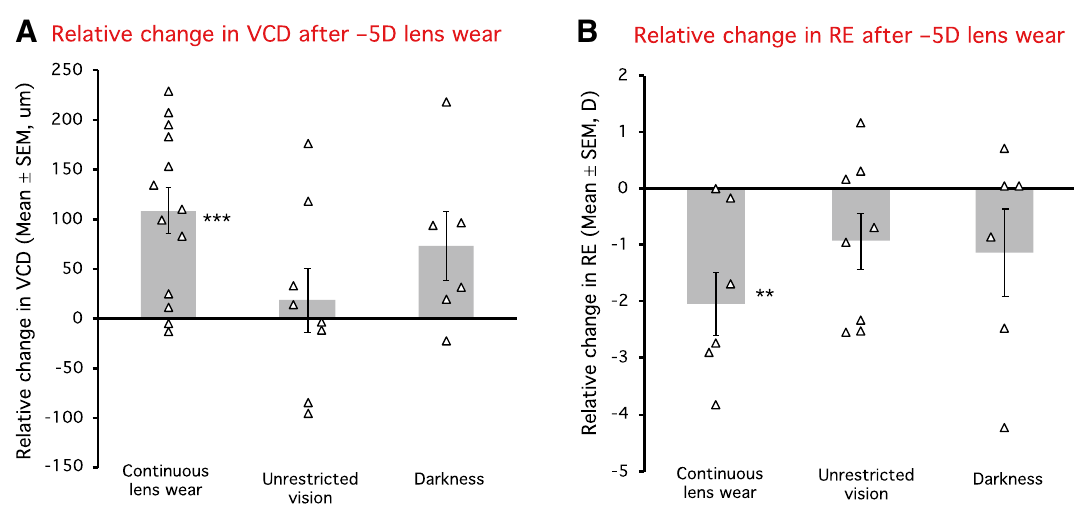
Figure 4. The relative change (the change in the lens-wearing eye relative to the change in the fellow eye) in vitreous chamber depth (VCD, A ) and refractive error (RE, B ) after wearing − 5D lenses for 4 weeks, either continuously or with interruptions. Triangles show individual animals, and bars represent the average for each group. RE was measured in 6 out of the 13 animals for the control group. n.s. Not significant; **p < 0.01; ***p <